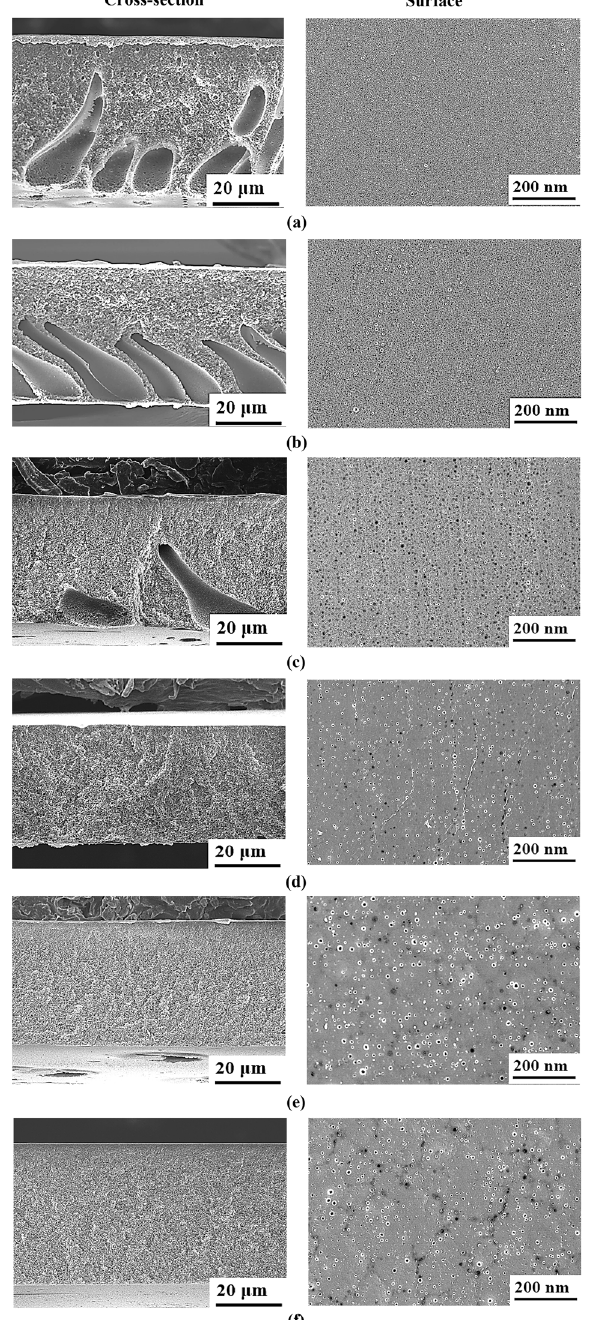
Fig. 4 Structure characterizations. SEM images of MMMs: ( a ) M0; ( b ) M2; ( c ) M3; ( d ) M6; ( e ) M8; ( f ) M12.